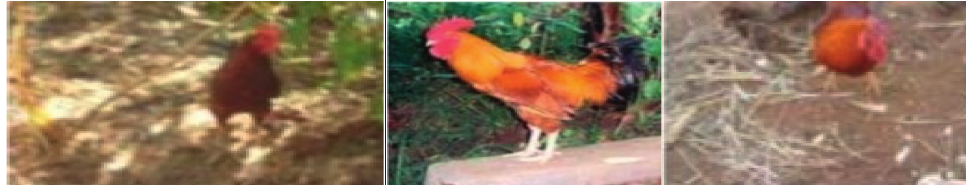
Figure 2: Red plumage color indigenous ecotypes. Source: Dawit et al., 2008.